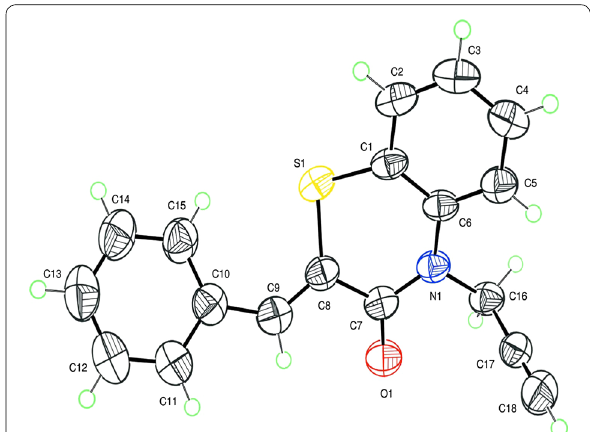
Fig. 2 The structure of compound 5, showing the atom-umbering scheme, with displacement ellipsoids drawn at the 30% probability